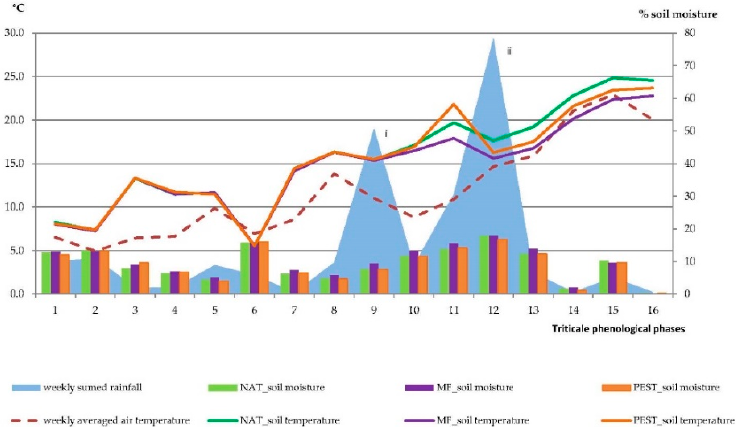
Figure 2. Above- and underground thermal-humidity conditions of sampling sites. i P = 50.69 mm, ii P = 78.37